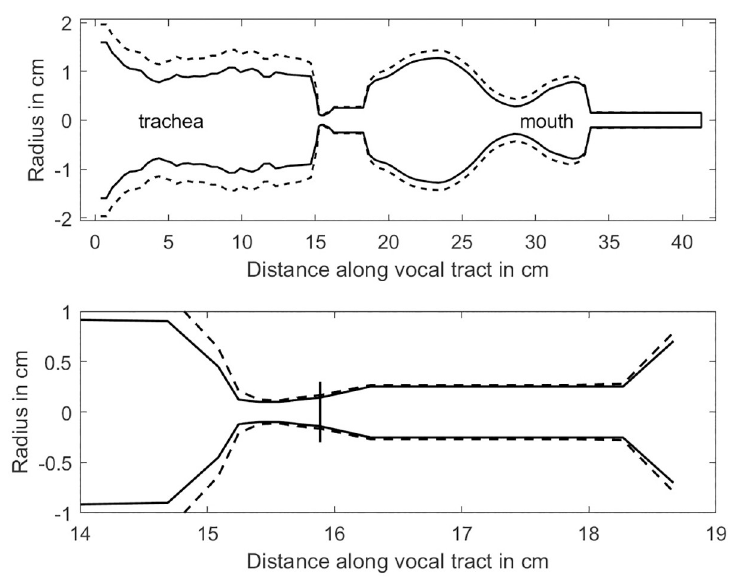
Fig 8. Expansion of the airway in a simulation model with a 3.0 mm diameter oral semi-occlusion and a lung pressure of 2.5 kPa. The stiffness of the epilaryngeal airway wall was increased to prevent expansion. (Top) entire airway, and (bottom) glottal and epilaryngeal